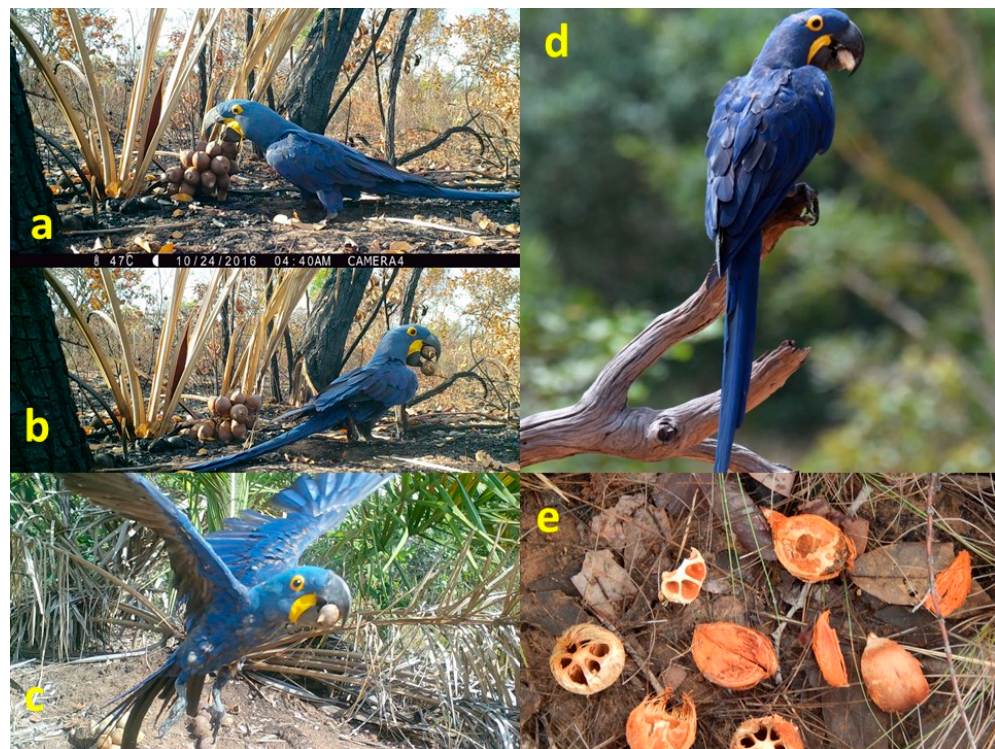
Figure 3. Dispersal process of bush layer palms ( Attalea barreirensis and Attalea eichleri ), as revealed by camera trapping. Hyacinth macaws landed and walked to the ground-level bunches of fruits ( a ) to pick up one or two at once and walked to the surroundings ( b ) to deflesh and ultimately consume the seeds, or they flew ( c ) to distant perching trees ( d ) to handle the fruits. Defleshed, predated, and undamaged nuts were easily found under perches ( e ). Photographs were taken by camera traps (a,b,c), Manuel de la Riva (d), and Fernando Hiraldo (e).